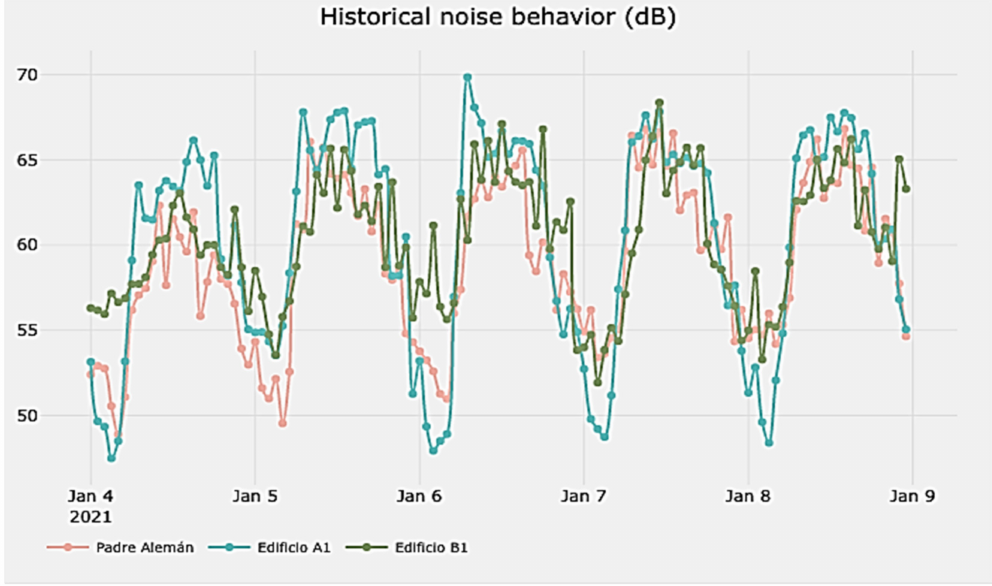
Figure 6. Hourly aggregated noise level time series between 4 and 8 January